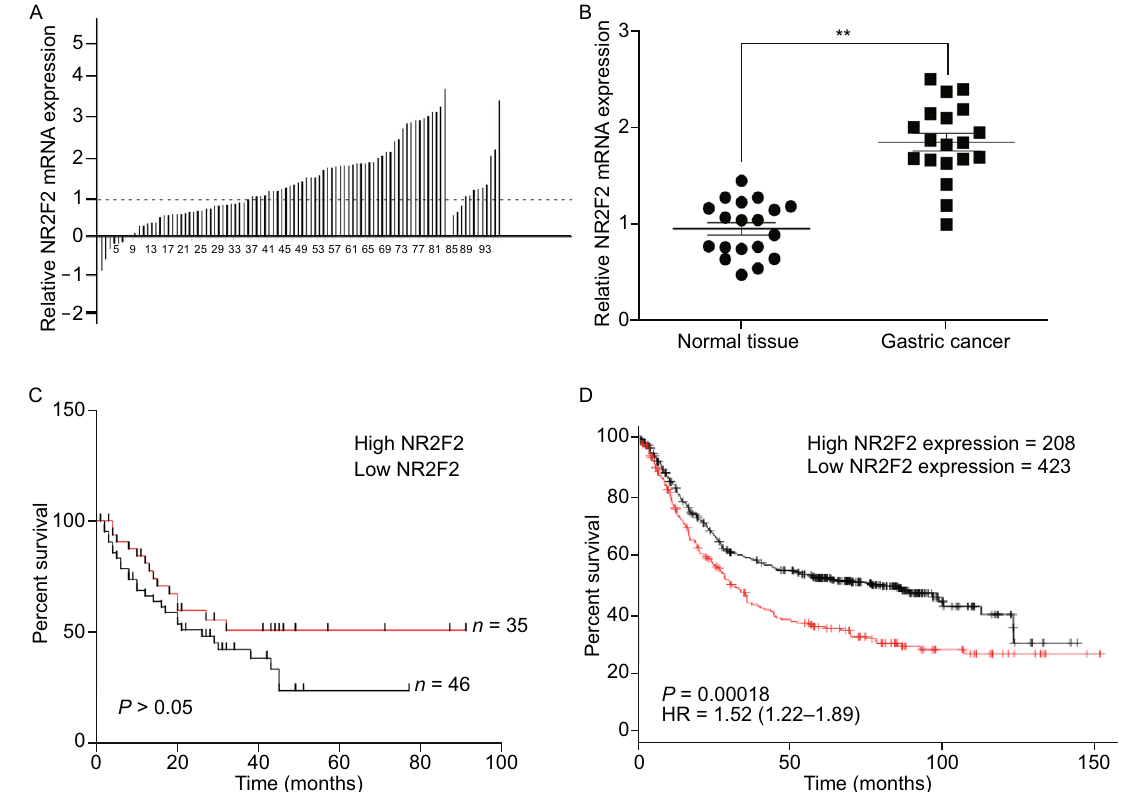
Figure 1. NR2F2 is up-regulated in human gastric cancer tissues and High NR2F2 level have poor clinical outcome. (A) The expression of NR2F2 in human gastric cancer tissue samples from oncomine database. (B) qRT-PCR analysis of NR2F2 expression in human gastric cancer tissue samples and their matched normal gastric tissues from 19 gastric cancer patients. (C) The High expression of NR2F2 in human gastric cancer tissues have trends to poor clinical outcome by oncomine database. (D) The High expression of NR2F2 in human gastric cancer tissues have poor clinical outcome by Kalpan meier-Poitter. Scale bars, 100 μ m. * P < 0.05, ** P < 0.01, *** P <